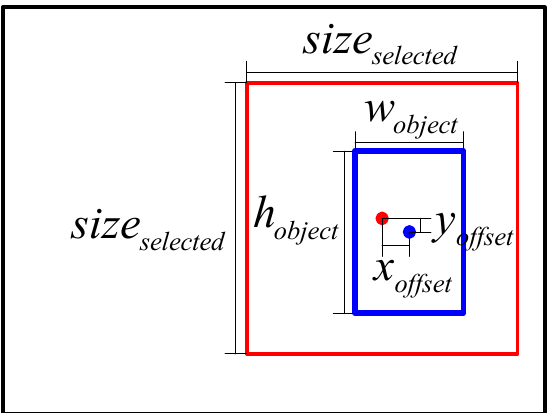
Figure 5. Selected region. The blue point denotes the center of the target, and the blue box indicates the ground-truth bounding box. The red point denotes the point of interest proposed by the baseline selector, and the red box indicates the selected